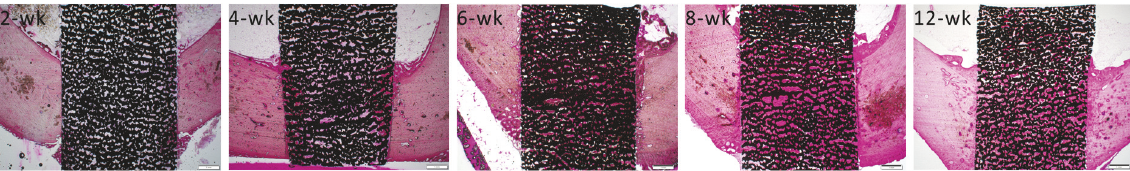
Figure 10: Histology at 2, 4, 6, 8, and 12 weeks demonstrates the continual progression of new bone integration and remodeling within the porous domains of the implant.